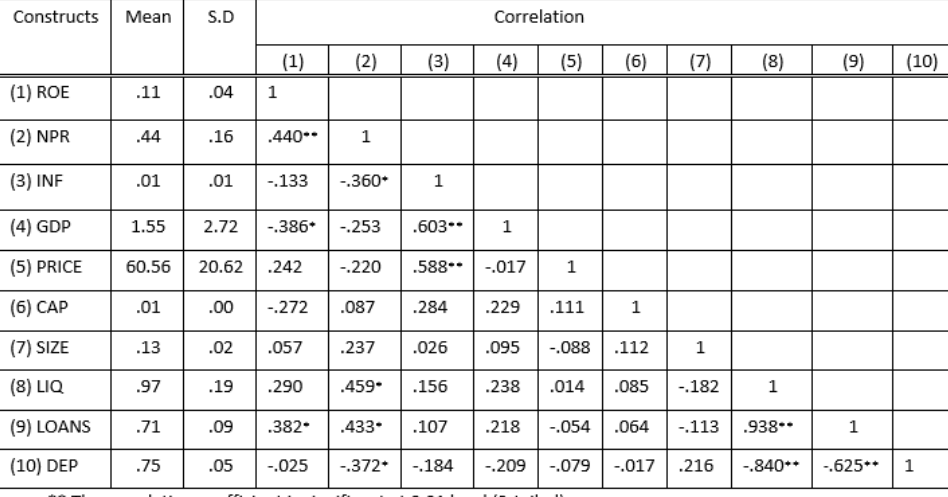
Table 2: Means, Standard Deviation and Correlation Matrix of the Study